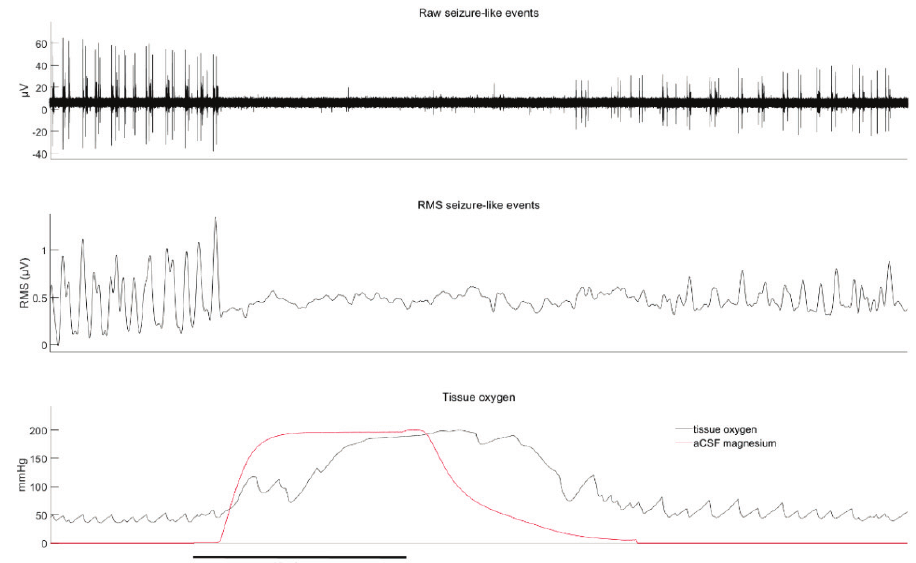
Figure 5. Example of changes in seizure-like event activity (top), root mean square (RMS) seizure-like activity (middle) and tissue oxygen (bottom) with the transition from no-Mg aCSF to normal aCSF and back to no-Mg (i.e., wash-in of magnesium ions). The red line in the bottom figure shows the estimated concentration time course for magnesium in the perfusion bath (normalized to its maximum value and × 200 for visual scaling).